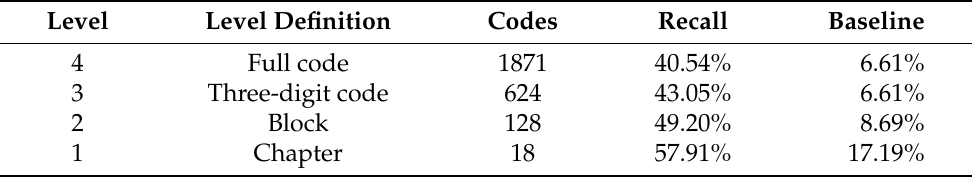
Table 7. ICD code